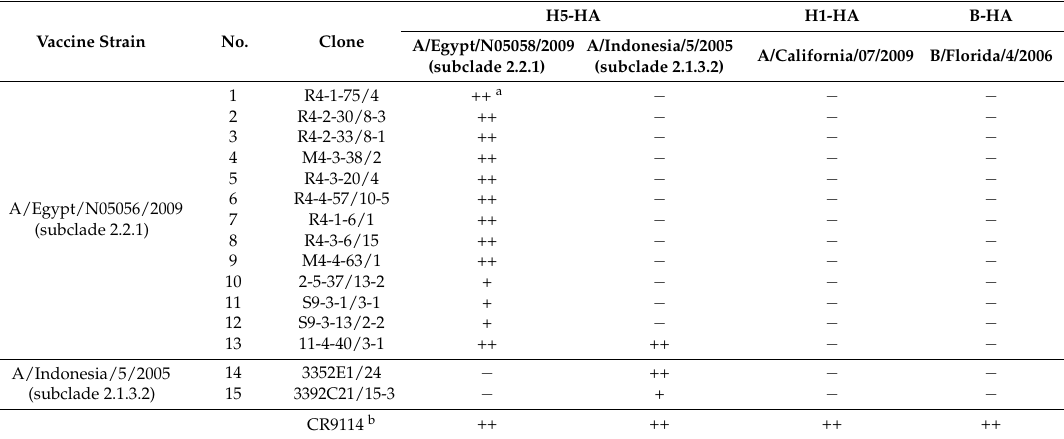
Table 3. Reactivity of the human mAbs with the recombinant HA.